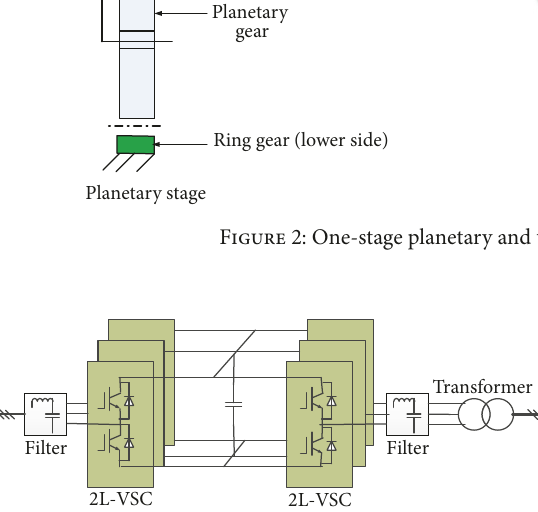
Figure 3: Two-level back-to-back voltage source converter